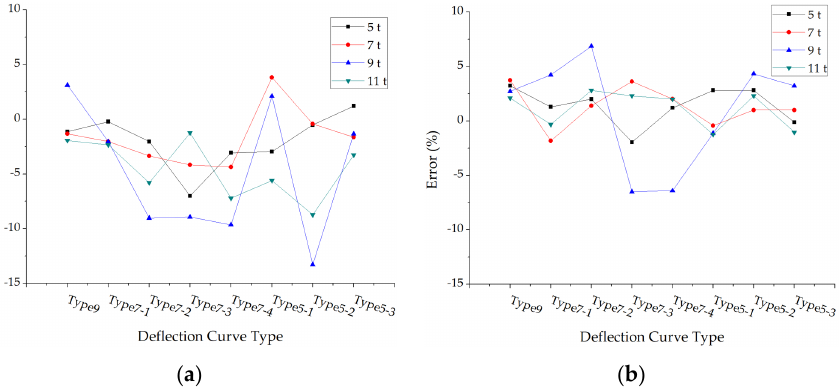
Figure 8. The average errors of back calculated base modulus: ( a ) The average errors under different deflection curve types; ( b ) The average errors under different axle loads.